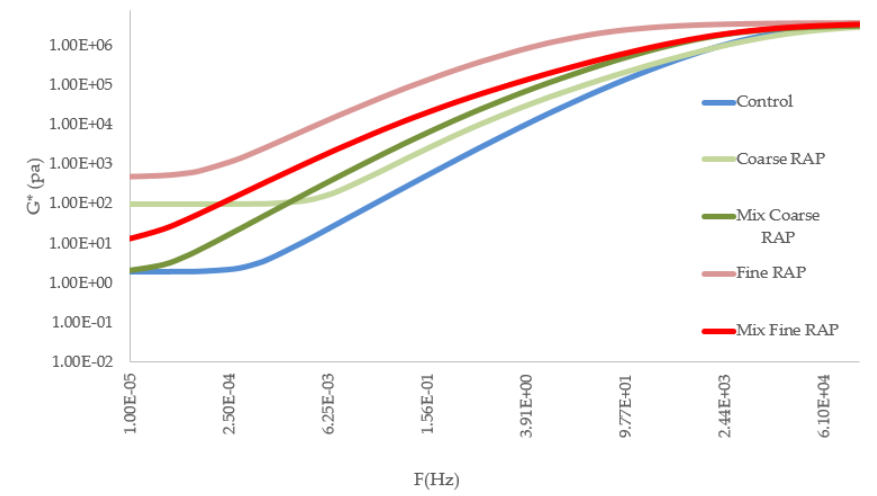
Figure 6. G* master curve at 10 °C of recovered binder (2S2P1D model).